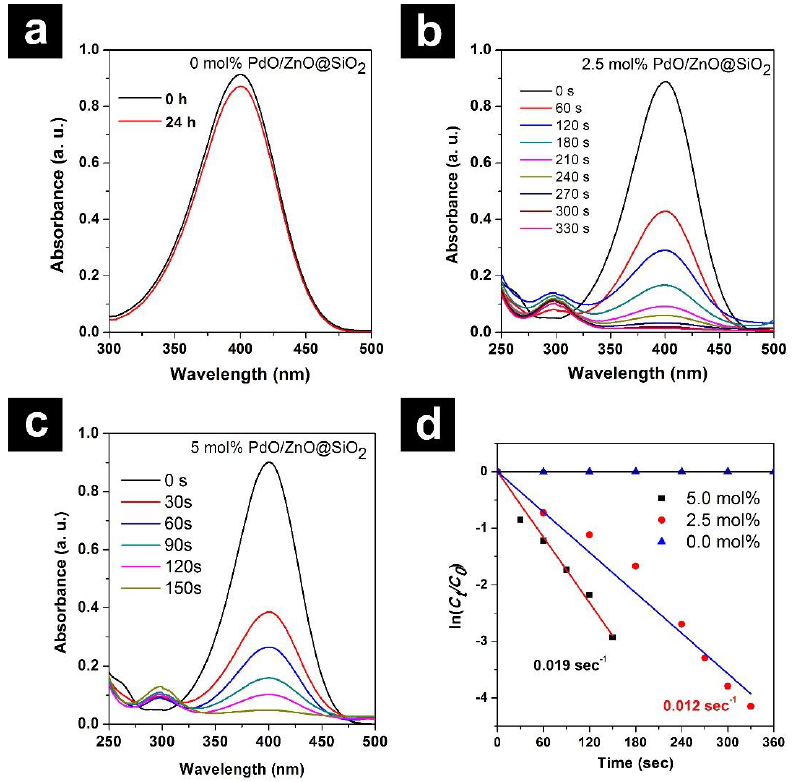
Figure 7. Time-dependent UV-vis absorption spectra for the reduction of 4-NP over different amount of catalyst, 0 mol % ( a ); 2.5 mol % ( b ); 5 mol % ( c ); and Plot of ln( C t / C 0 ) versus time for the reduction of 4-NP with different amount of catalyst ( d ).